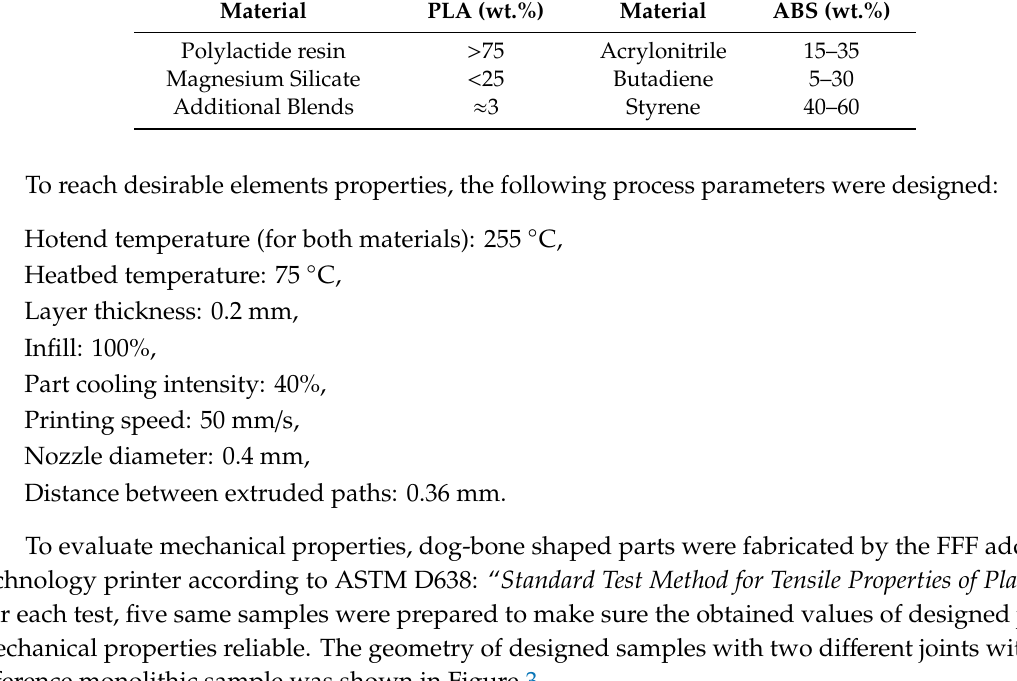
Table 1. Base chemical composition of used materials.